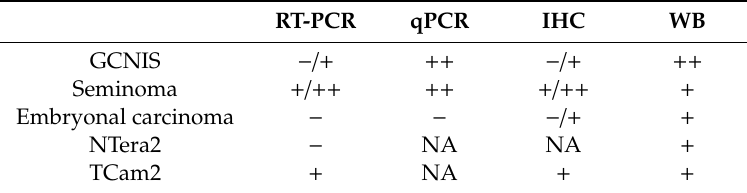
Table 1. Detection of LHCGR by di ff erent